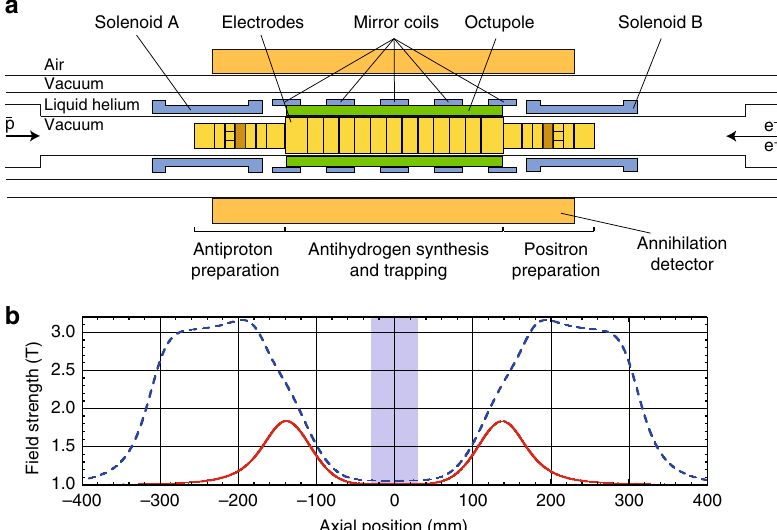
Fig. 1 The ALPHA-2 central apparatus. a ALPHA-2 geometry, drawn to scale except for the radial extent of the annihilation detector. The inner diameter of the Penning – Malmberg electrodes is 44.35 mm in the central region of the atom trap and 29.6 mm at either end. Antiprotons enter from the left in this view, while positrons and electrons are loaded from the right . b Magnetic fi eld strength on axis with the atom trap energised (the external solenoid responsible for producing a uniform 1 T fi eld is not shown). The solid curve ( red ) shows the fl attened atom trap fi eld used in ref. 5 . The dashed curve ( blue ), shows the on-axis fi eld during stacking; the left and right solenoids a , b increase the fi eld from 1 to 3 T for enhanced capture, cyclotron cooling and rotating wall ef fi ciency of, as appropriate, positrons, electrons and